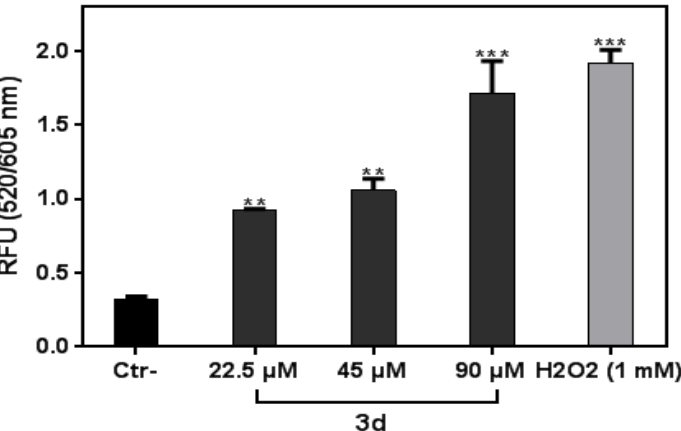
Figure 6. The compound 3d induced reactive oxygen species production in K562 cells. Cells were treated with 3d at different concentrations for 2 h. H 2 O 2 (1 mM) was used as the positive control. Data are the mean of two independent experiments. All data were statistically significant ( p < 0.05). **, and *** denote p < 0.01, and 0.001, respectively.